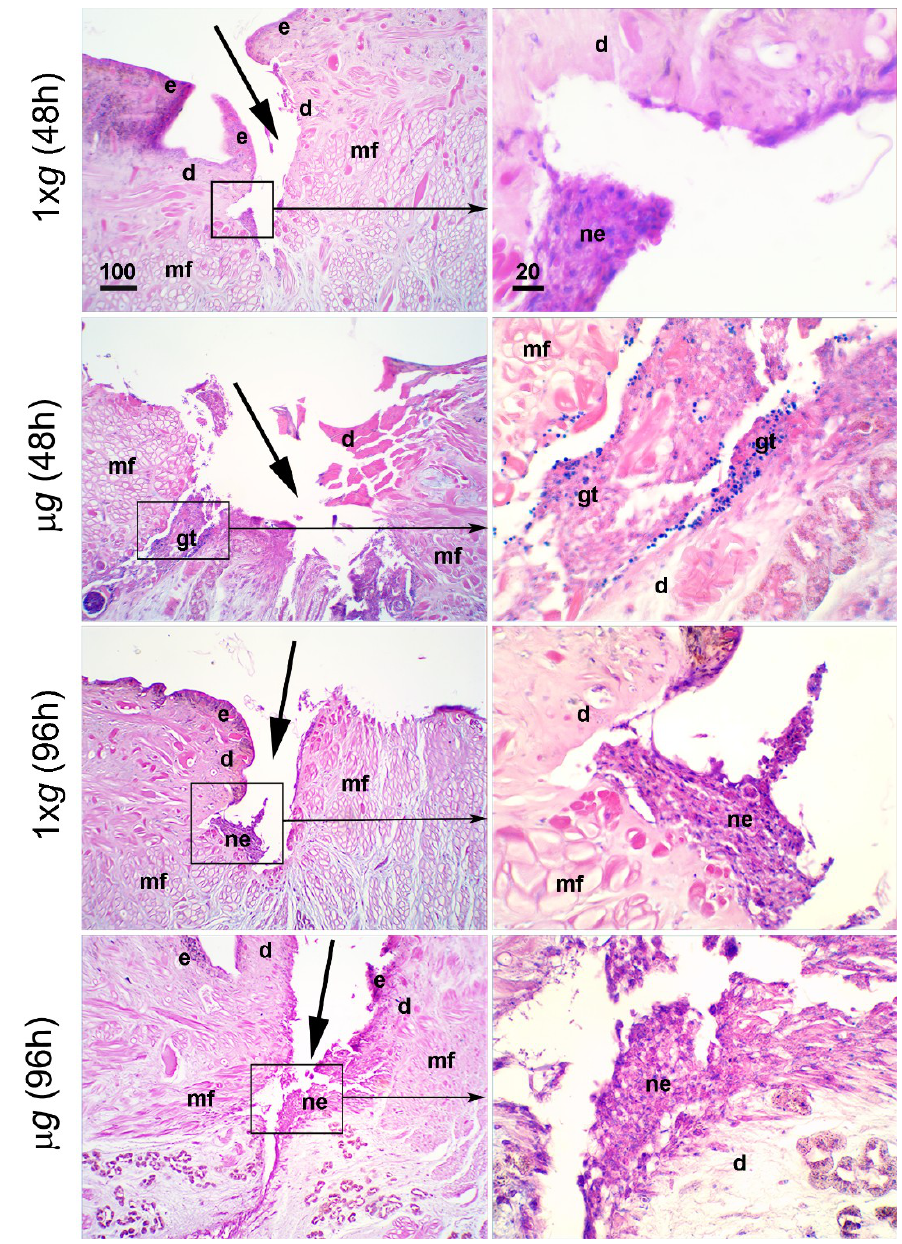
Figure 1. Effect of modeled μg on in vivo model of sutured wound healing ( Hirudo medicinalis ): state of the wound after 48 h and 96 h exposure. Hematoxylin–eosin stained cross sections. The panels show the state of the wounds on the back of the leeches (arrows) in the 1 × g controls and in the animals exposed to modeled μg for 48 h or 96 h. Letterings are as follows: e, epidermis; d, dermis; mf, muscle fibers; ne, neo-epidermis; gt, granulation tissue. Calibration bars are in μm, as indicated.